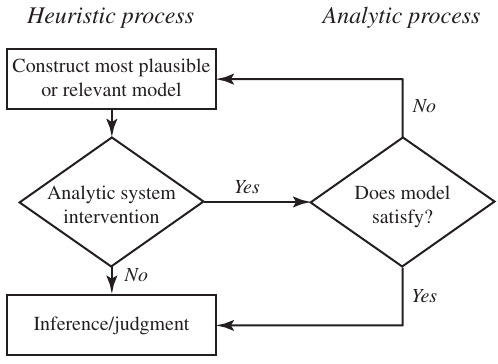
FIG. 1. Heuristic-analytic theory of reasoning and decision making